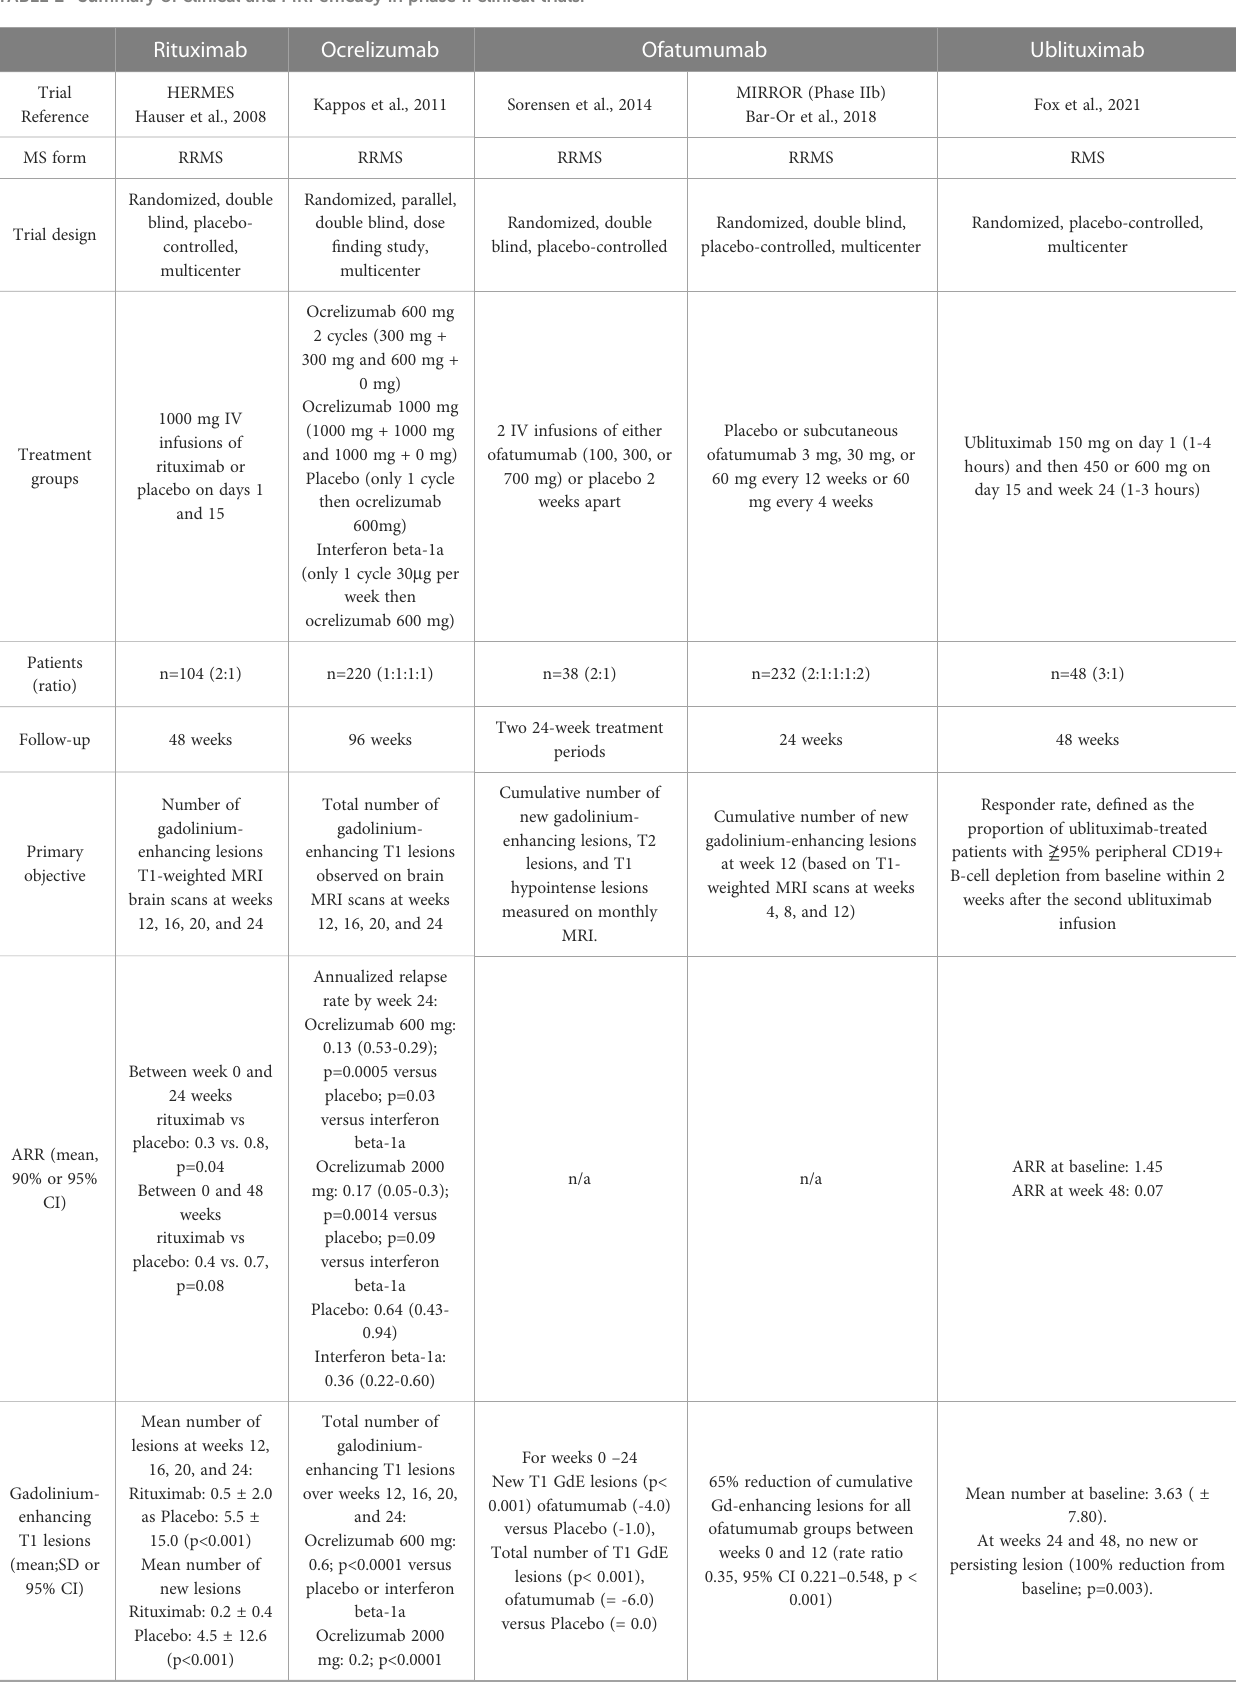
TABLE 2 Summary of clinical and MRI ef fi cacy in phase II clinical